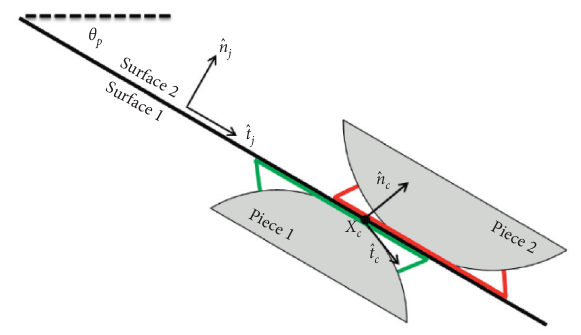
Figure 3: A smooth joint model (from PFC software manual